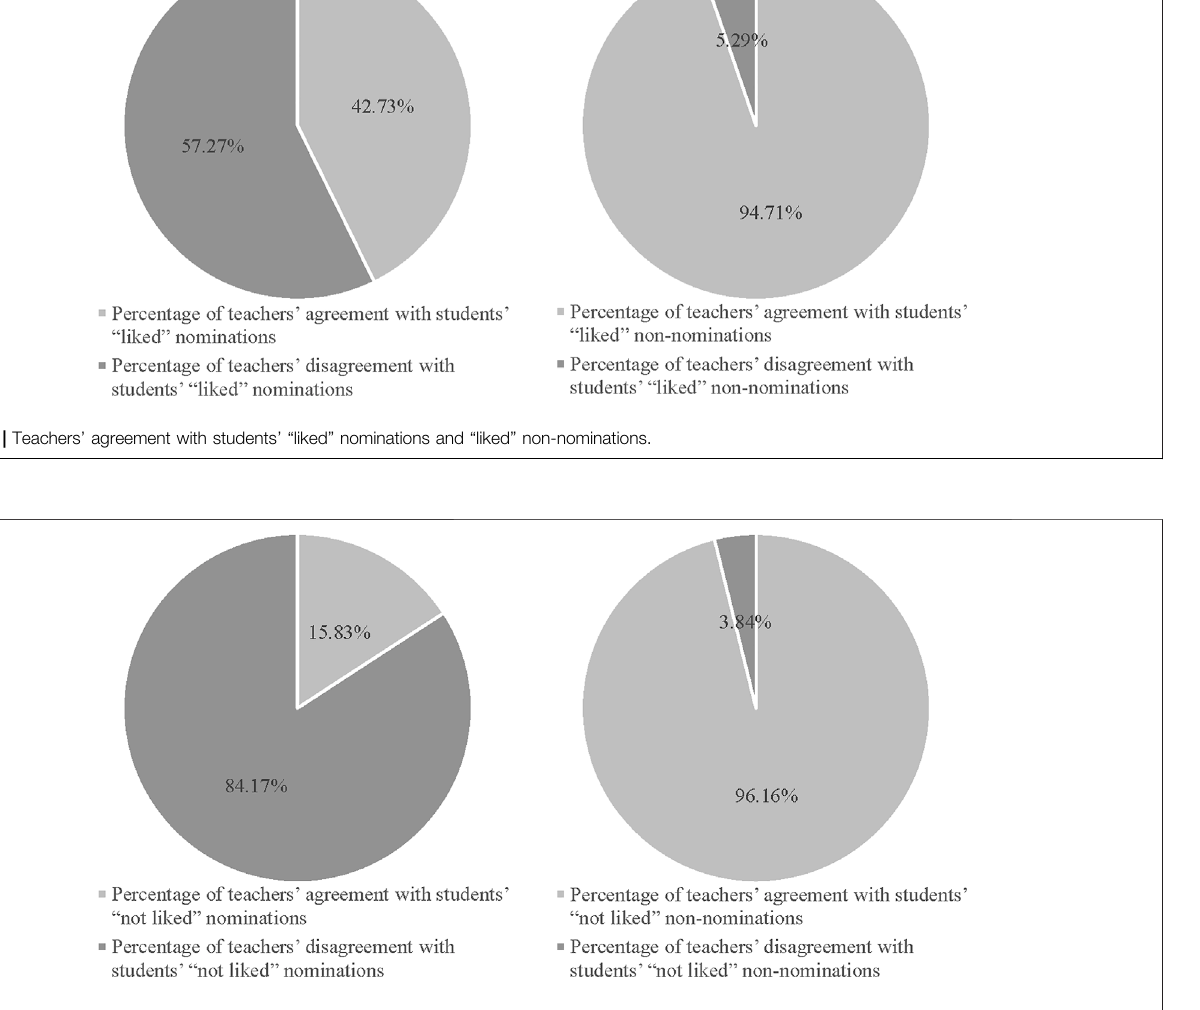
FIGURE 2 | Teachers ’ agreement with students ’ “ not liked ” nominations and “ not liked ”